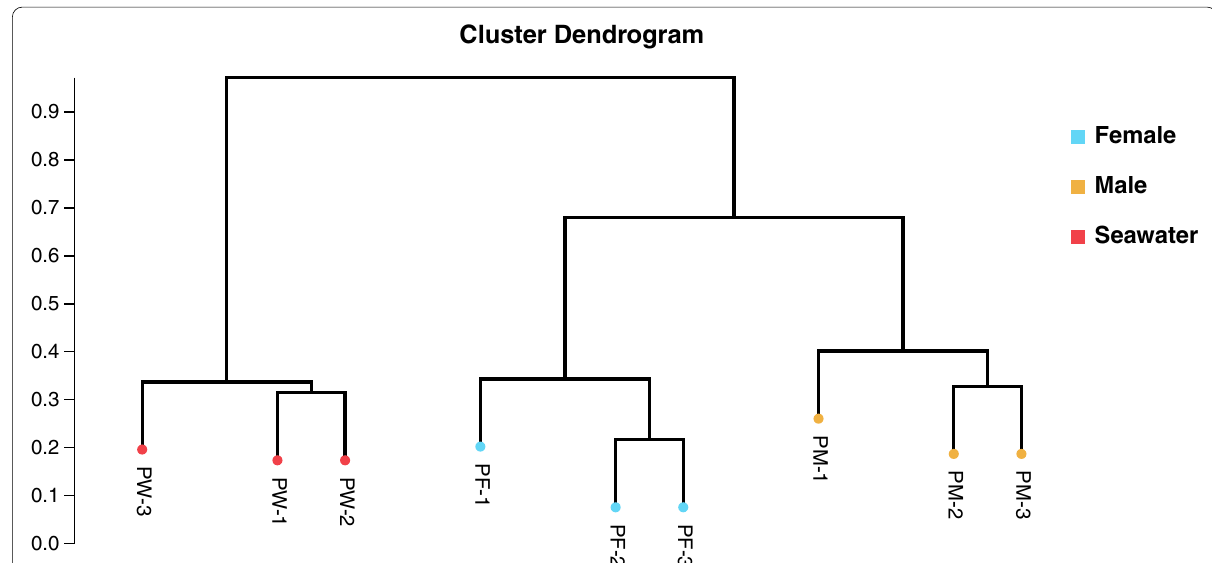
Fig. 3 UPGMA analysis based on Bray-Curtis distance showing the distance relationship between